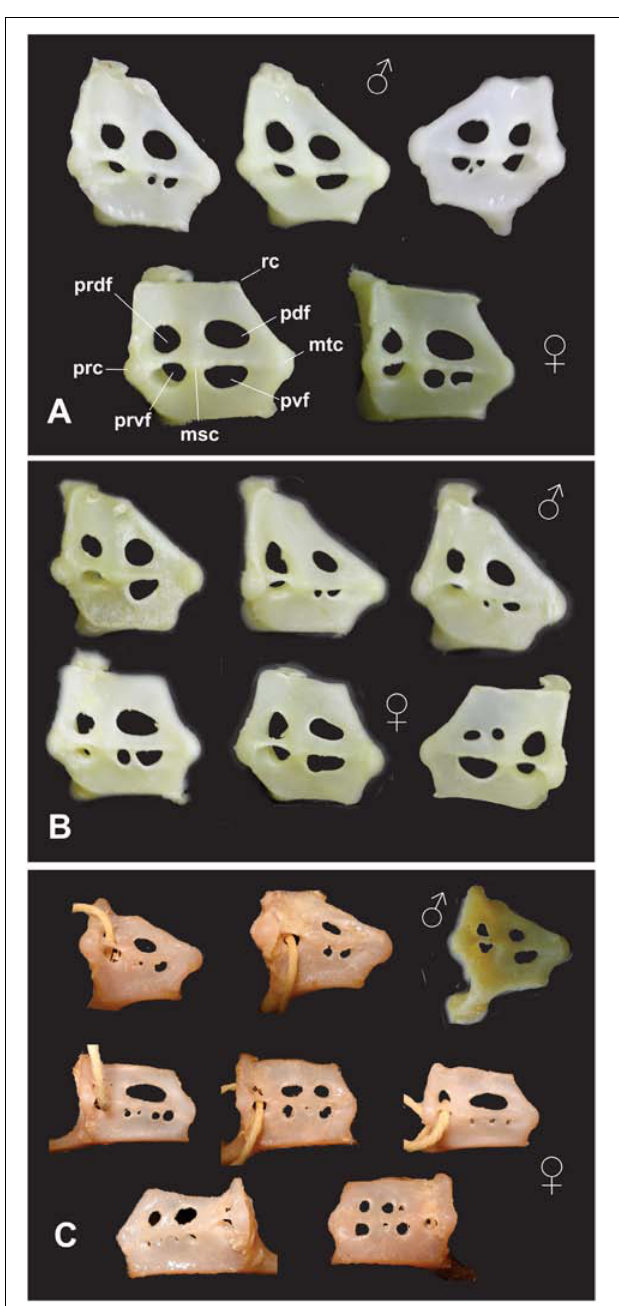
FIGURE 2 | Scapulocoracoid morphotypes observed in 3 species of Psammobatis : (A) P. rudis (above males, below females); (B) P. normani (above males, below females); and (C) P. lentiginosa (above males, below females. Msc = mesocondyle, mtc = metacondyle, pdf = postdorsal foramina or fenestra, prc = procondyle, prdf = predorsal fenestra, prvf = preventral fenestra, pvf = postventral foramina or fenestra, and rc = rear corner.